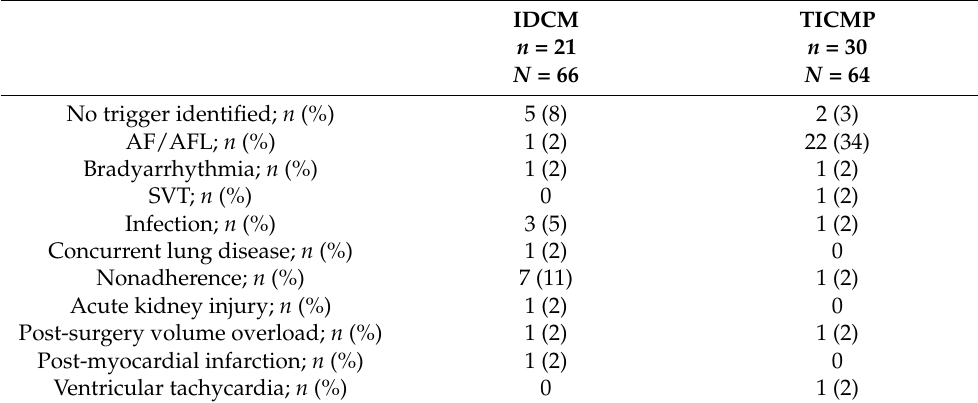
Table 5. Triggers for 1st heart failure